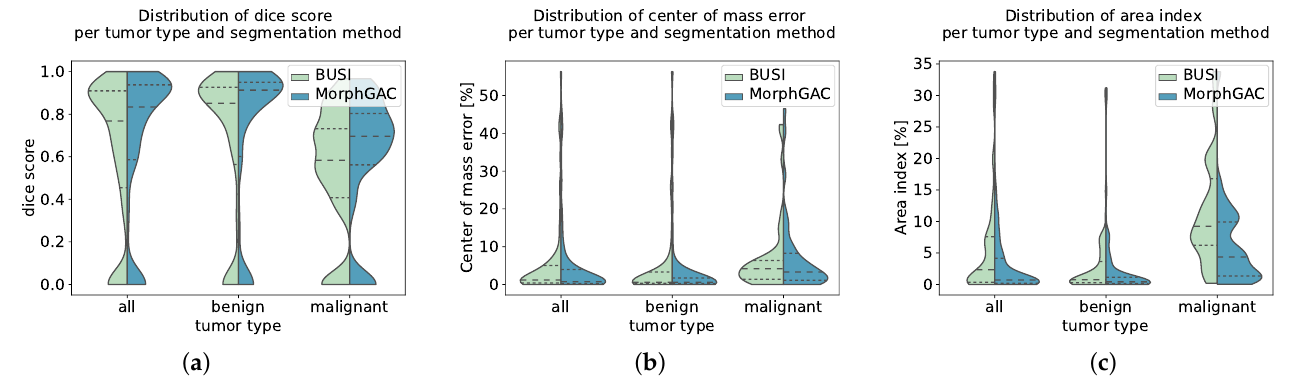
Figure 5. Distributions of the three metrics per tumor type for the two segmentation methods—BUSI (left) MorphGAC (right). ( a ) Dice distribution, ( b ) center error distribution, ( c ) area index distribution. The dashed lines represent the median score and upper and lower quartiles. Table 2. Quantitative evaluation by comparing the optical segmented mask to both the original BUSI reference masks and the BUSI masks re-segmented by the MorphGAC